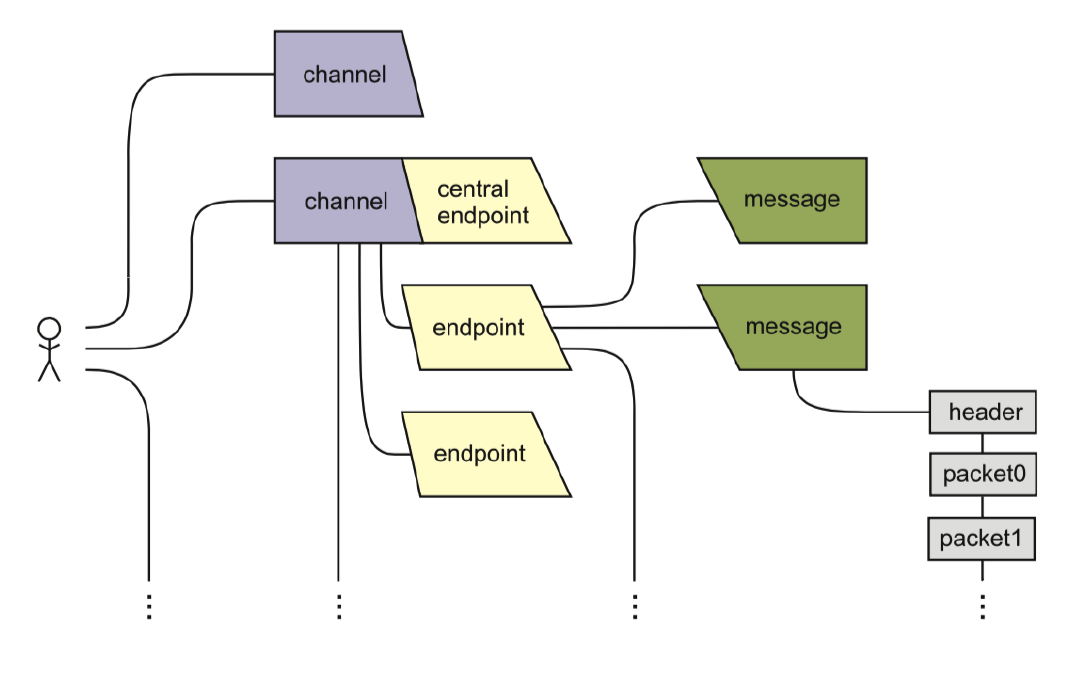
Figure 5. Concept diagram of the Masked Authenticated Messaging (MAM) functionality